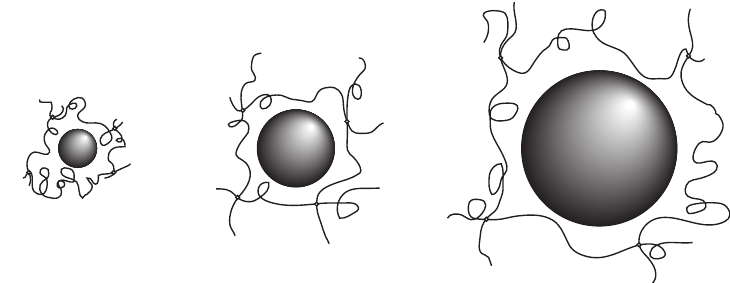
Figure 3. The schematic representation of Equation (7). The size of the probe molecules is different, but the ratio of the size and the correlation length, R h / ξ , is similar in these three cases. The diffusion coefficient of the probe molecule that is normalized by the diffusion coefficient of the probe molecule in water, D / D 0 , is almost the same in these